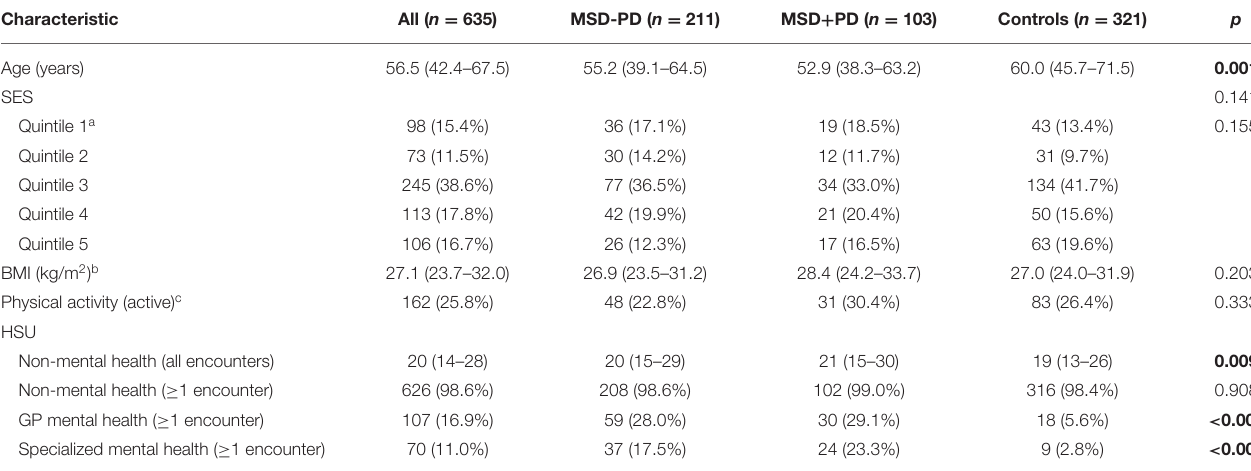
TABLE 1 | Characteristics of the study group and women with MSD-PD, MSD + PD, and controls. Characteristic